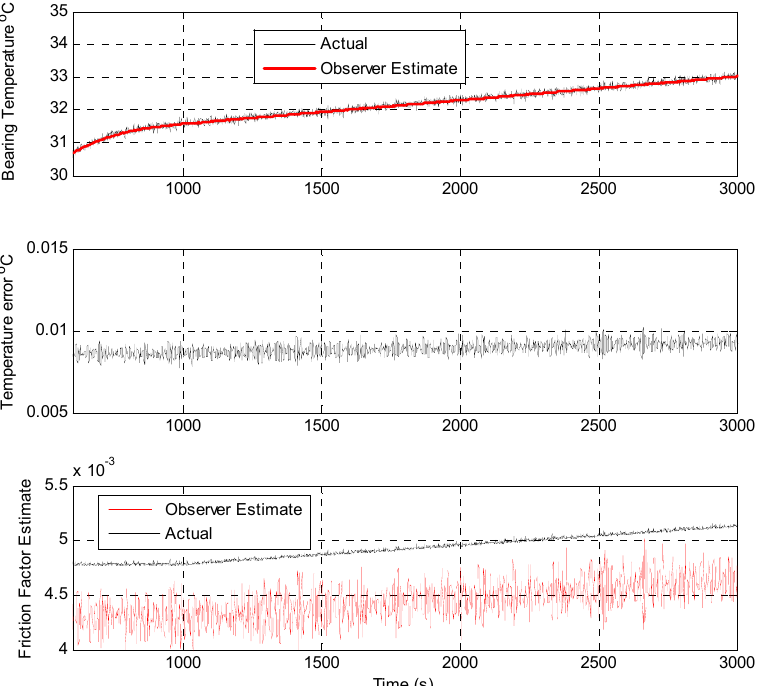
Figure 11. Comparative analysis of the Simulink-based and edge device-based observers (bearing friction factor fault case).